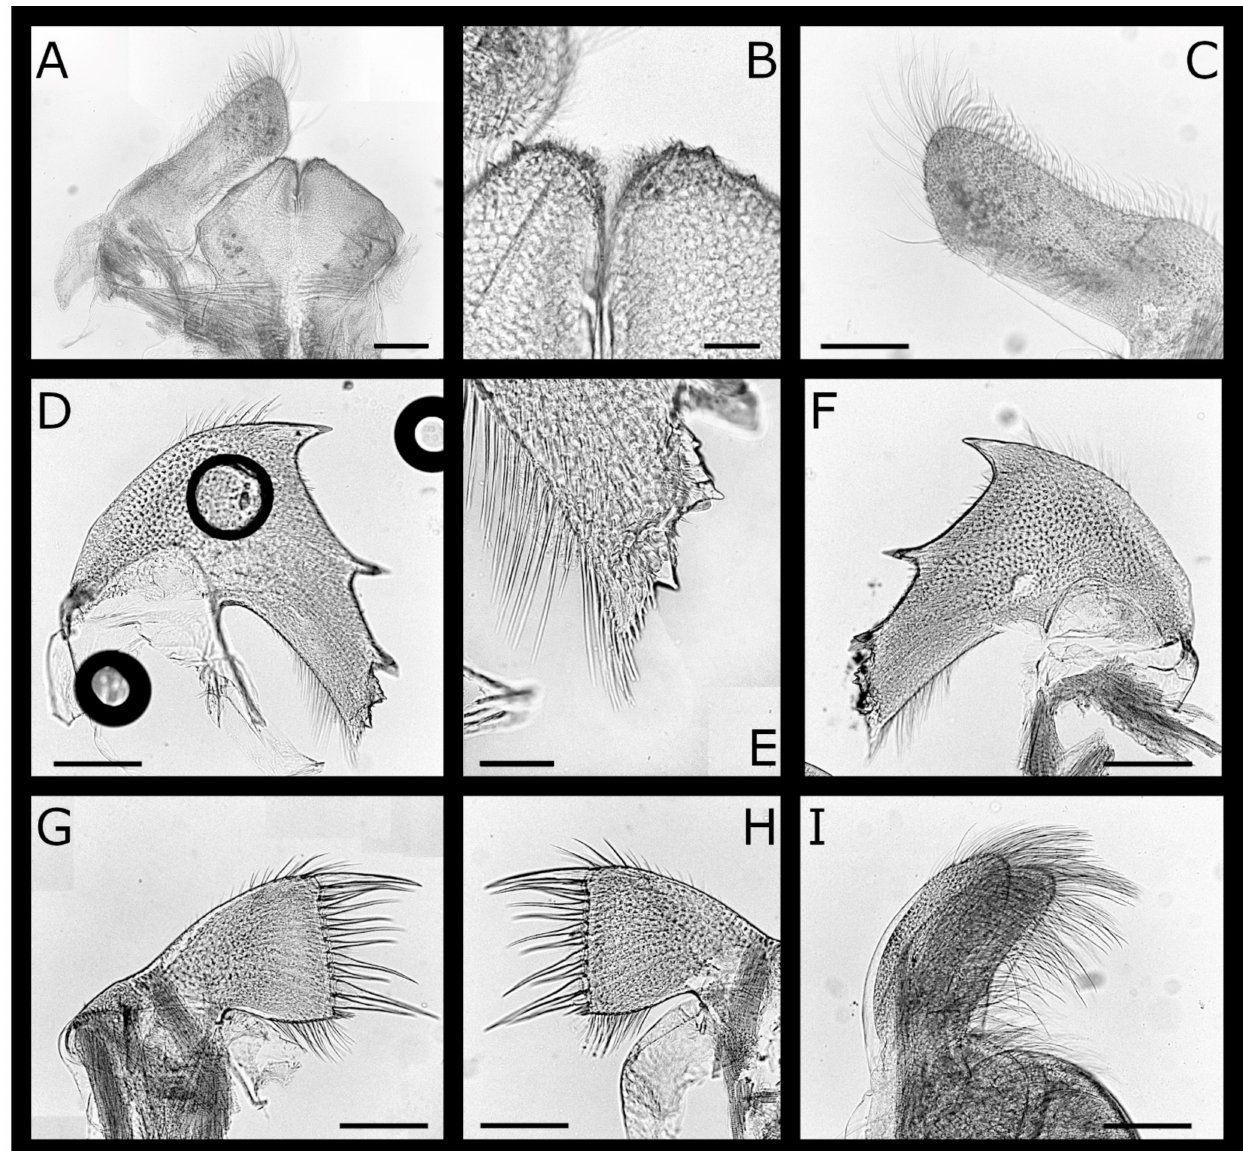
Figure 2. Acasta caveata sp. nov. mouthparts (all WAM C67716, holotype). ( A ) labrum and right mandibular palp; ( B ) crest of labrum; ( C ) left mandibular palp; ( D ) left mandible; ( E ) close up of inferior angle of mandible showing fourth and fifth serrated teeth; ( F ) right mandible; ( G ) left maxillule; ( H ) right maxillule; ( I ) left and right maxilla, lateral view. Scale bars: A, C–D, F–I = 200 µ m; B, E = 50 µ